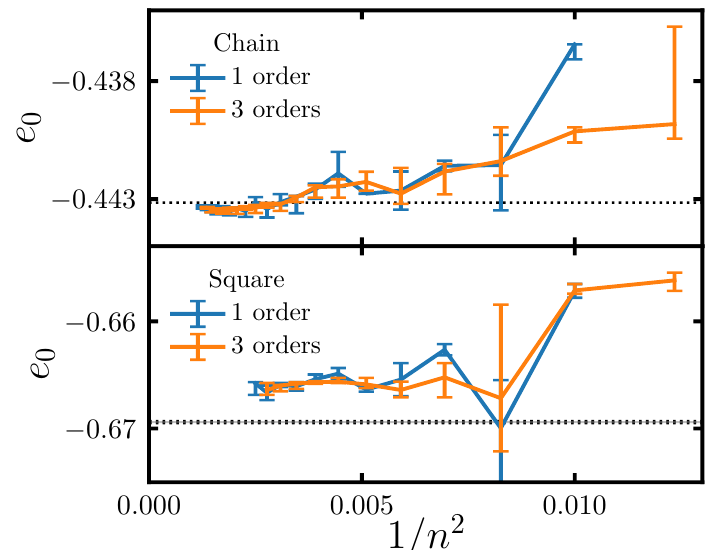
Figure 5: Best values of the ground-state energy e (with corresponding uncertain- 0 ties) for several orders n (blue) and groups of 3 orders [ n − 1, n + 1 ] (orange), as a function of 1 / n 2 . On the top panel: the chain limit, and on the bottom panel: the square lattice. The dotted lines stand for the exact result for the chain [ 55 ] , and the quantum Monte Carlo result for the square lattice [ 54,72 ]